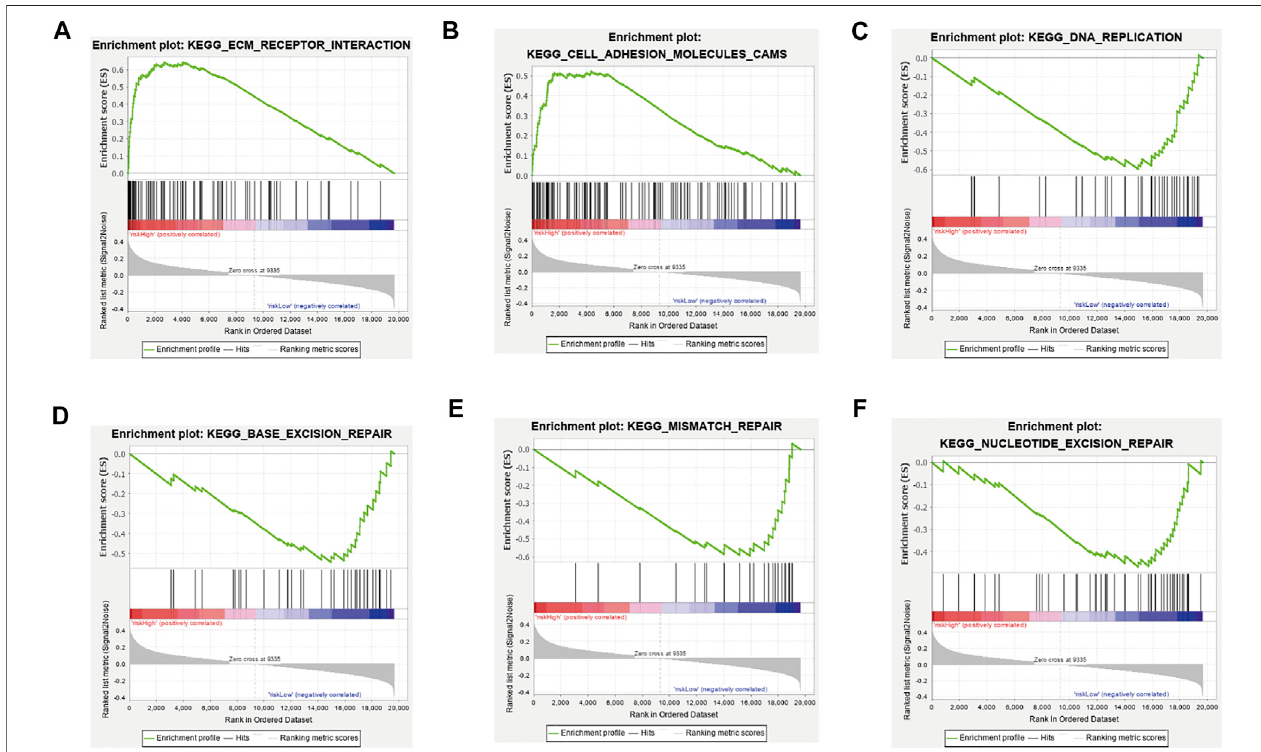
FIGURE5| Geneset enrichment analysisbetweenthehigh-risk groupand low-riskgroup. (A) ECMreceptor interaction, (B) celladhesion molecules(CAMs) were enriched in the high-risk group, (C) DNA replication, (D) base excision repair, (E) mismatch repair, and (F) nucleotide excision repair was enriched in the low-risk